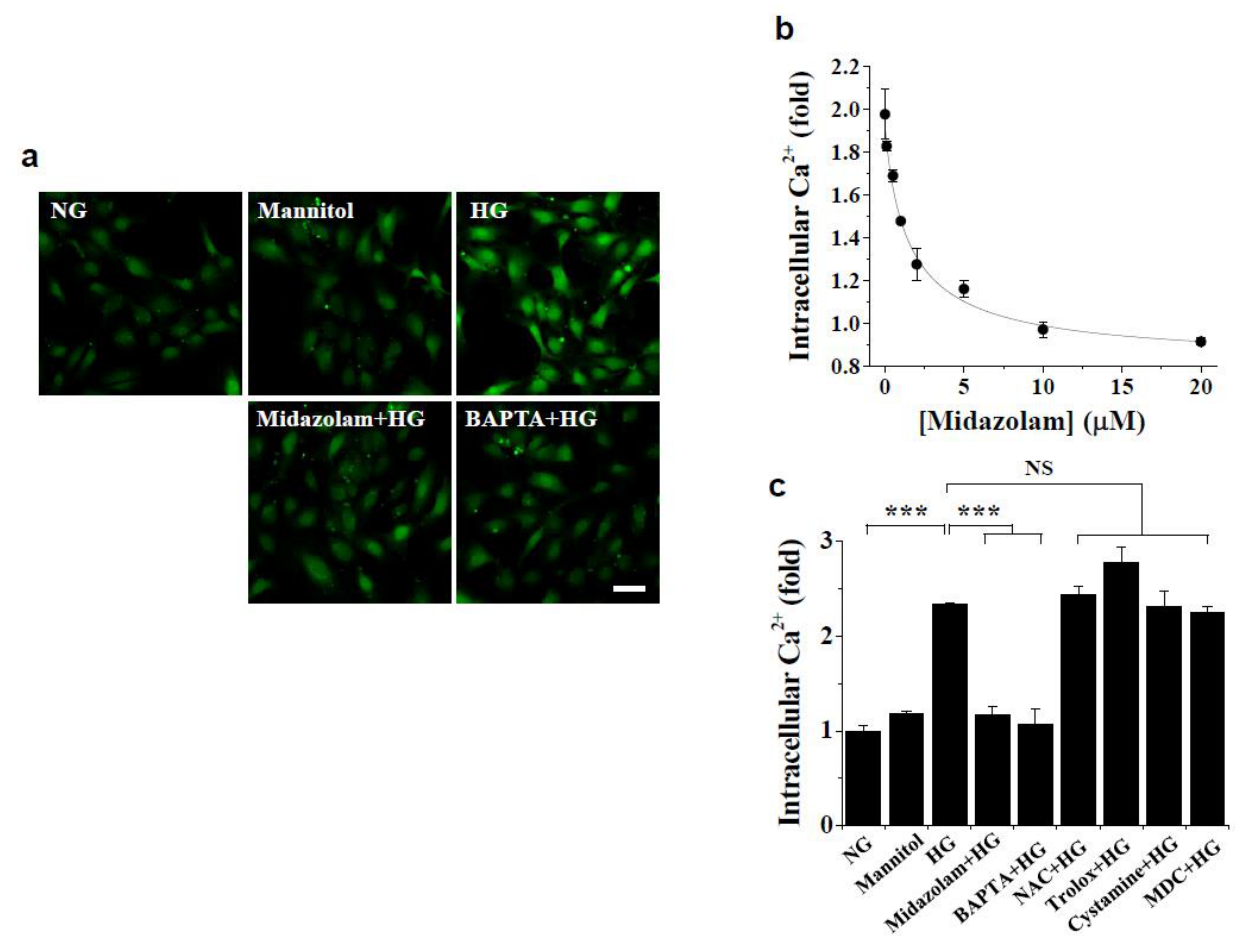
Figure 3. Effects of midazolam and inhibitors on high glucose-induced increase in intracellular Ca 2+ levels in human glomerular microvascular endothelial cells (HGECs). HGECs were treated for 3 days with normal glucose (NG) or high glucose (HG) at the indicated concentrations of midazolam (MDZ) or in the presence of 20 µ mol/L midazolam, 5 µ mol/L BAPTA-AM, 1 mmol/L N-acetyl cysteine (NAC), 0.5 µ mol/L Trolox, 50 µ mol/L cystamine, or 20 µ mol/L monodansylcadaverine (MDC). Mannitol was used as an osmotic control. Intracellular Ca 2+ levels were visualized by confocal microscopy ( a ) and quantified by measuring fluorescence intensities ( b , c ). ( a ): Representative images of intracellular Ca 2+ levels. Scale bar, 50 µ m. ( b ): Midazolam inhibits high glucose-induced elevation of intracellular Ca 2+ levels in a concentration-dependent manner. ( c ): Effect of various inhibitors on high glucose-induced intracellular Ca 2+ elevation. Results are expressed as the mean ± standard deviation (SD) from three independent experiments. *** p < 0.001; NS,